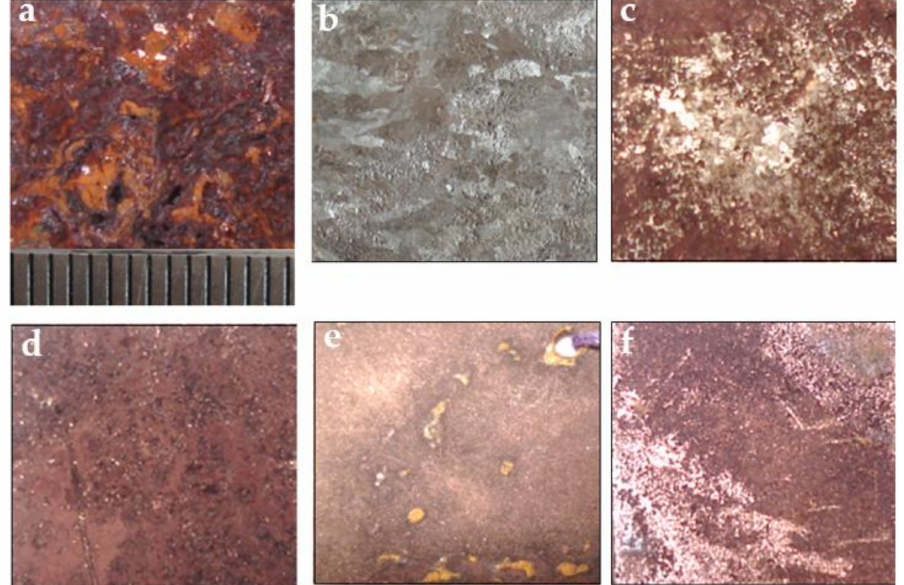
Figure 5. Macro-photograph of corrosion samples before ( a ) and after descaling ( b ) for steel 0, ( c ) for steel 1, ( d ) for steel 2, ( e ) for steel 3, and ( f ) for steel